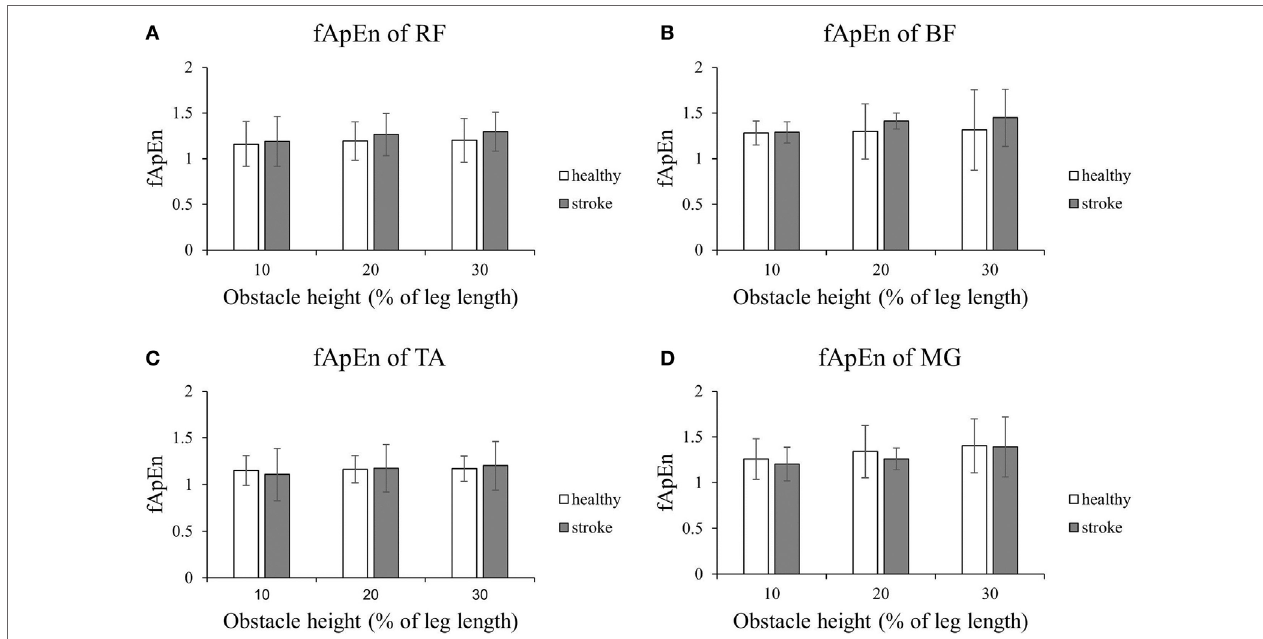
FigUre 4 | The details of fuzzy approximate entropy (fApEn) values of each height for leading limb during swing phases. (a) The fApEn values of rectus femoris (RF); (b) the fApEn values of biceps femoris (BF). (c) The fApEn values of tibialis anterior (TA); (D) the fApEn values of medial gastrocnemius (MG).